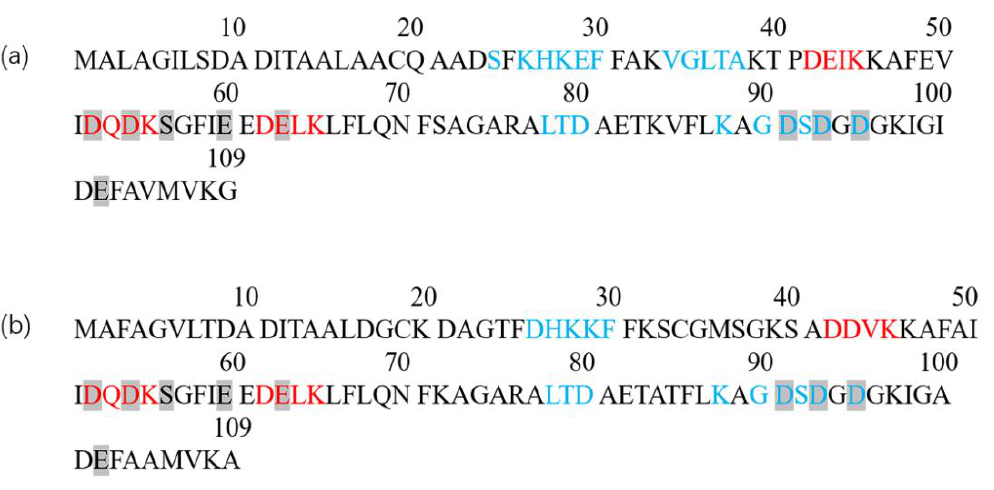
Figure 3. Amino acid sequence of parvalbumin isoforms PV-I ( a ) and PV-II ( b ) in mandarin fish. The amino acid coded in red was corresponded to the epitope of Baltic cod allergen M Gad c1. The amino acid coded in blue matched to the mimotope by phage display technique. The gray shaded section was a calcium-binding site found through the UniProt website.